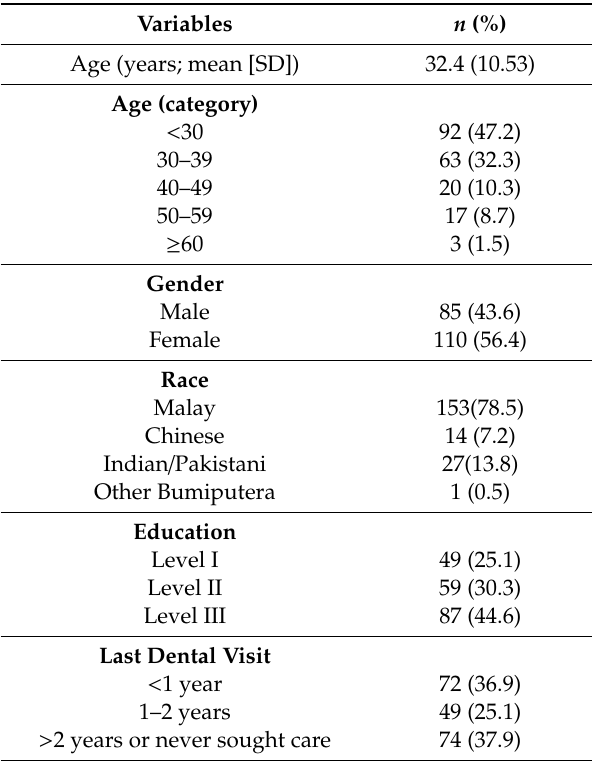
Table 1. Sociodemographic characteristics of the respondents ( n =